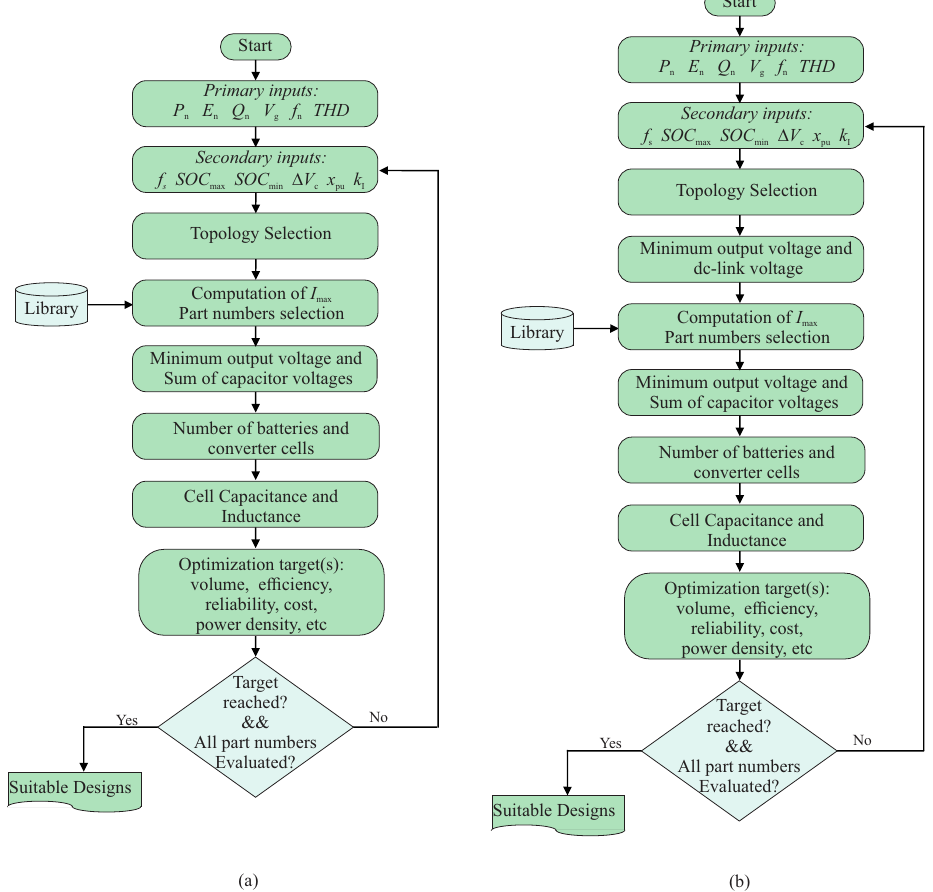
Figure 3. Design flowchart of the ES-STATCOM: ( a ) DES topologies. ( b ) CES